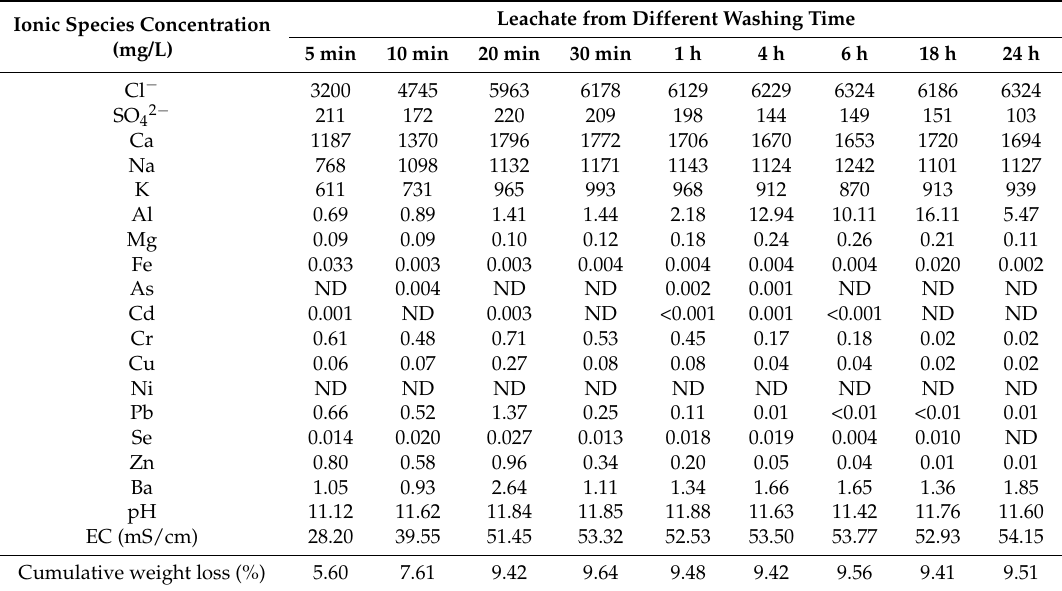
Table 2. Ionic species concentration in leachate from different washing time. Ionic Species Concentration